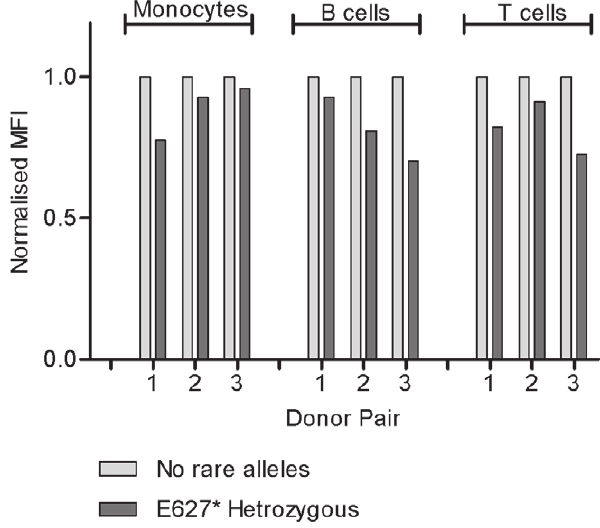
Figure 3. Reduced IFIH1 expression within monocytes, B and T cells in donors heterozygous for the rare premature stop codon SNP, rs35744605 (Glu627X). Mean fluorescent intensity (MFI) of IFIH1 expression for each donor heterozygous for rs35744605 is normalised to the MFI of the paired control individual.